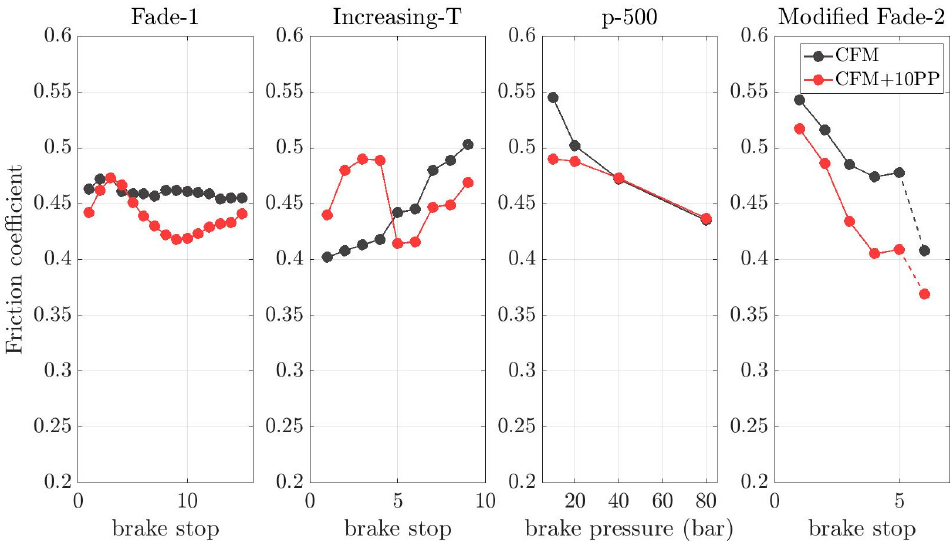
Figure 9. Typical behavior of the friction coefficient during the Fade-1, Increasing Temperature and Pressure line 500 °C of SAE J2522, and Modified-Fade-2 for the tested friction materials CFM and CFM with 10 PP.